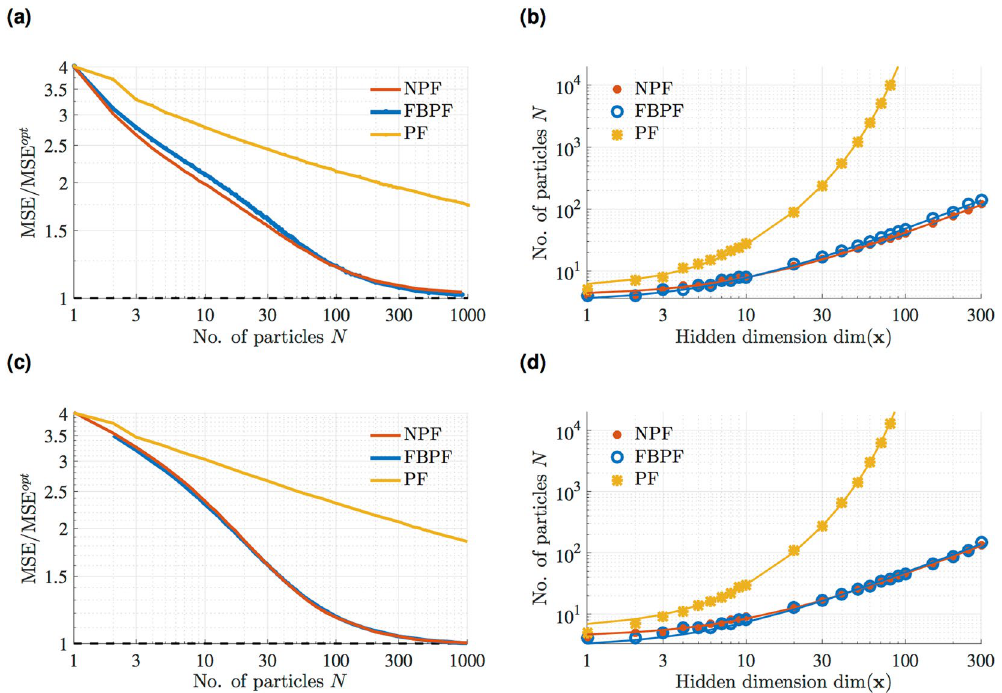
Figure 5. The NPF avoids the ‘curse of dimensionality’. ( a ) Filtering performance in terms of MSE (normalized to optimal performance, in this case = . MSE d 0 5 opt , where d denotes the number of hidden dimensions) for varying number of particles for a linear model with high-dimensional hidden state-space ( d = 80). Both unweighted approaches NPF and FBPF outperform the (standard) weighted particle filter for a limited number of particles. ( b ) Number of particles needed to achieve a numerical performance < . MSE MSE 1 5 number of particles N needed for a standard (weighted) PF grows exponentially with d due to fast weight decay in higher dimensions. Contrarily, the unweighted approaches avoid the COD and the number of particles scales linearly with hidden dimensions. Solid lines correspond to linear ( = ⋅ + N d a d b ( ) , NPF: a = 0.38, b = 4.1 FBPF: a = 0.45, b = 3.2) and exponential ( N d c PF: c 0 = 47, c 1 = 0.07, c 2 = -2.4, c 3 = -42) least-squares fits. ( c , d ) Same as ( a , b ), but for nonlinear hidden dynamics with a bimodal stationary distribution. Least-squares fit as coefficients: a = 0.42, b = 4.2 (NPF), a = 0.45, b = 2.8 (FBPF), c 0 = 44, c 1 = 0.07, c 2 = -2.1, c 3 = -38